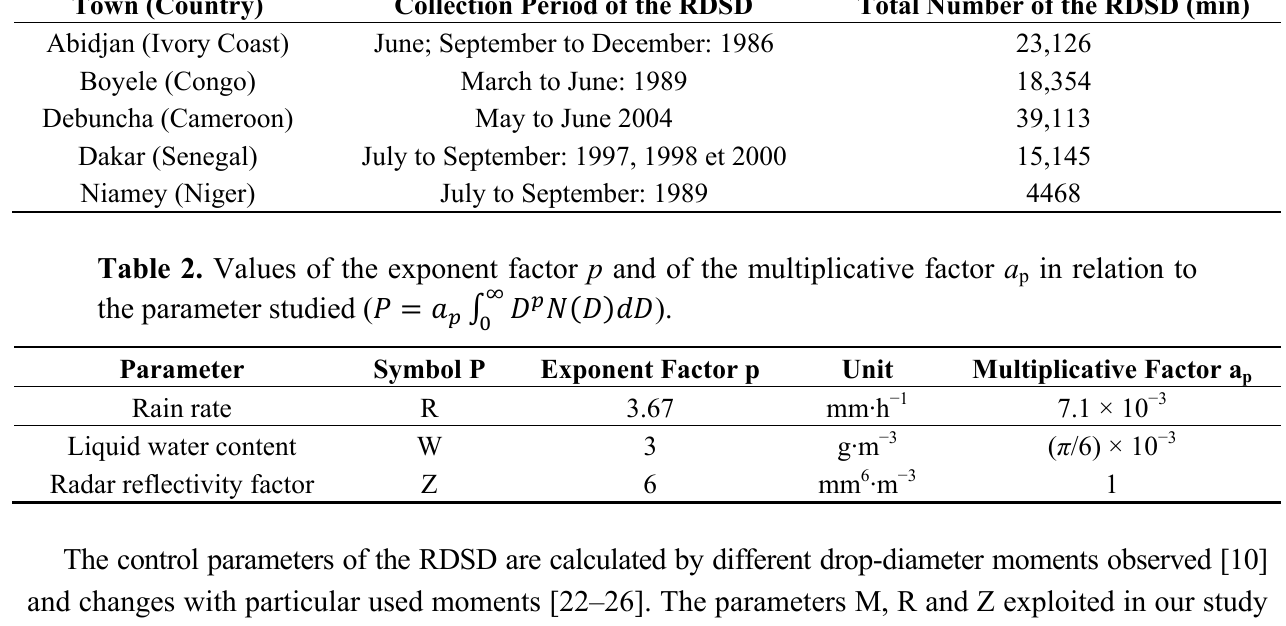
Table 1. Database and localities studied in sub-Saharan Africa.